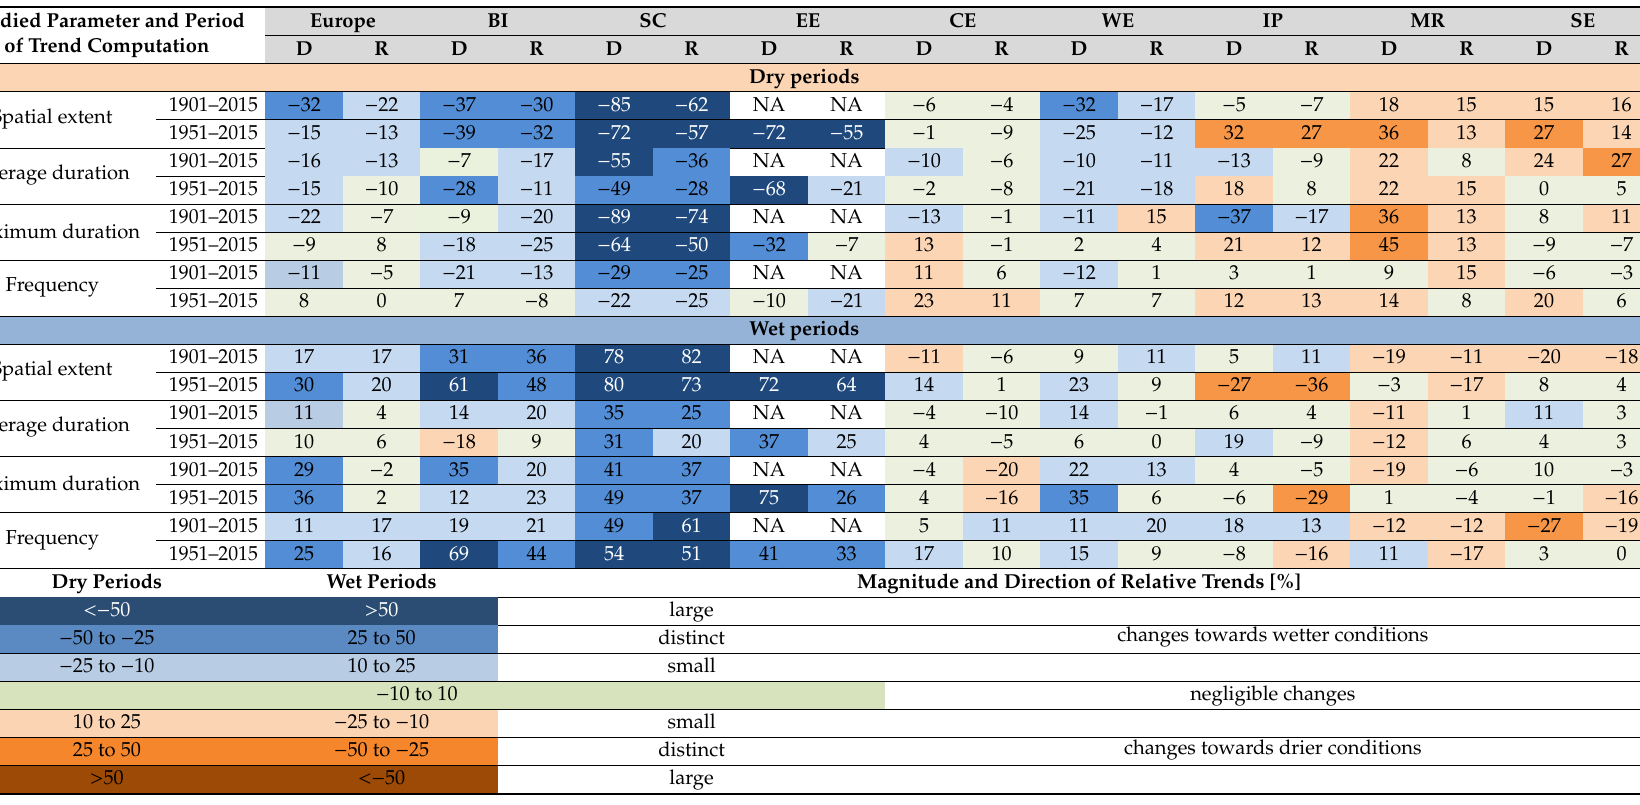
Table 6. Trends (simple linear regression; relative trends in percentage terms) of the annually averaged dry and wet period parameters for the two study periods 1901–2015 and 1951–2015. The results for two indices (D: deciles index, R: mRAI) are displayed for Europe and its eight sub-regions (for region abbreviations please refer to Figure 1). The background colors depict trend magnitude and direction (orange: drier conditions, blue: wetter conditions, green: negligible changes; for details see legend below the table). NA indicates that no trend has been computed due to the restricted data